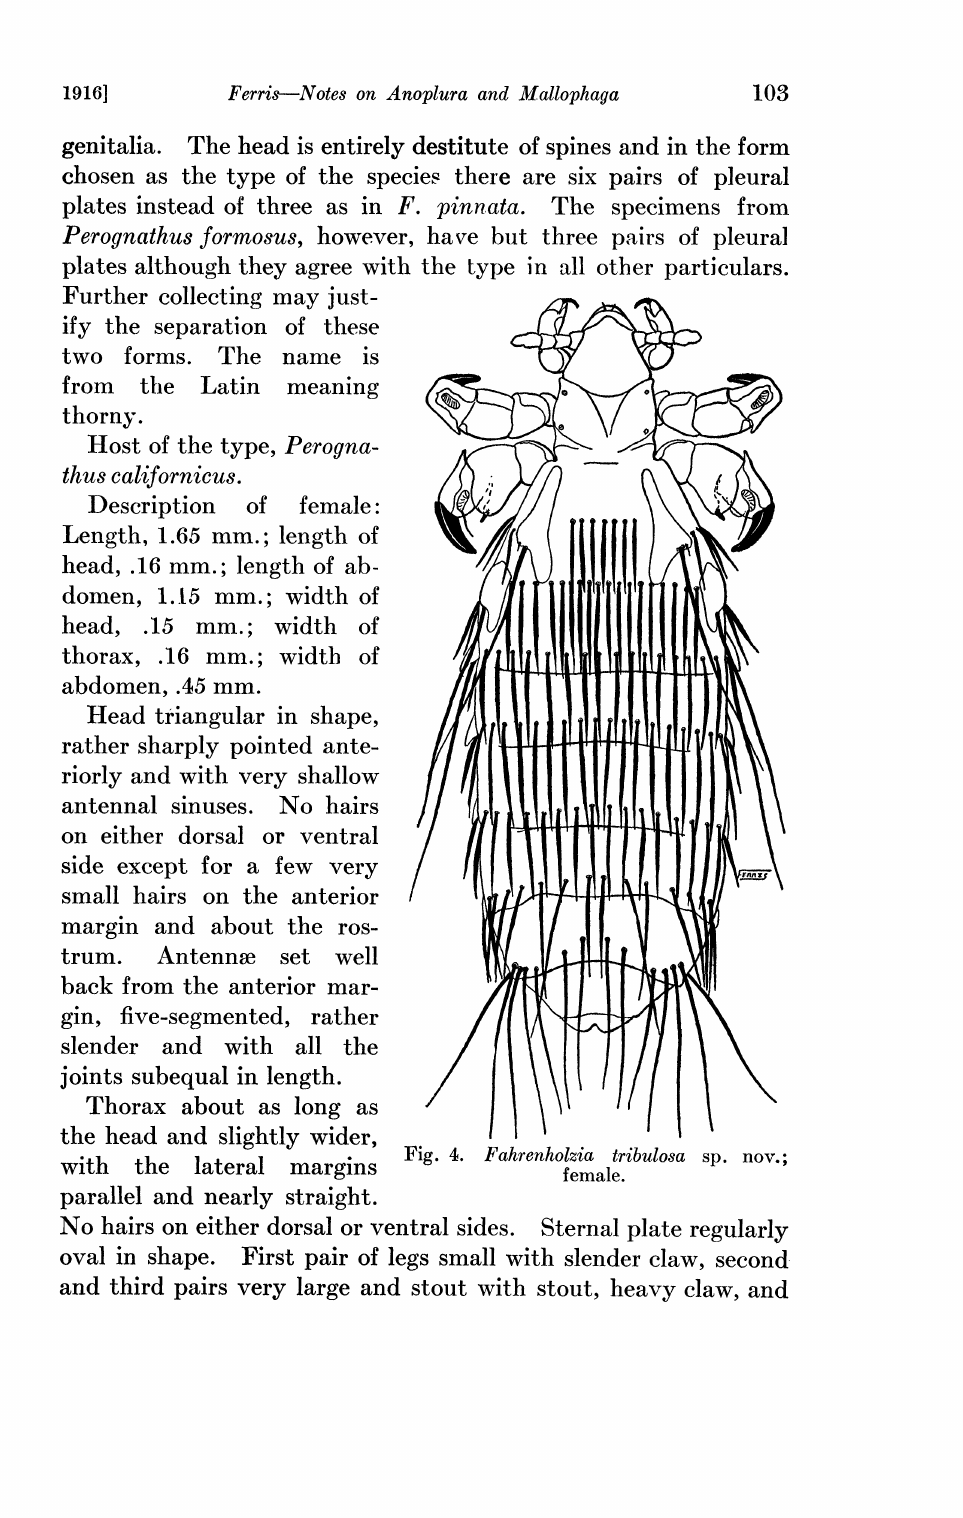
Fig. 4. Fahrenholzia tribulosa sp. nov.;